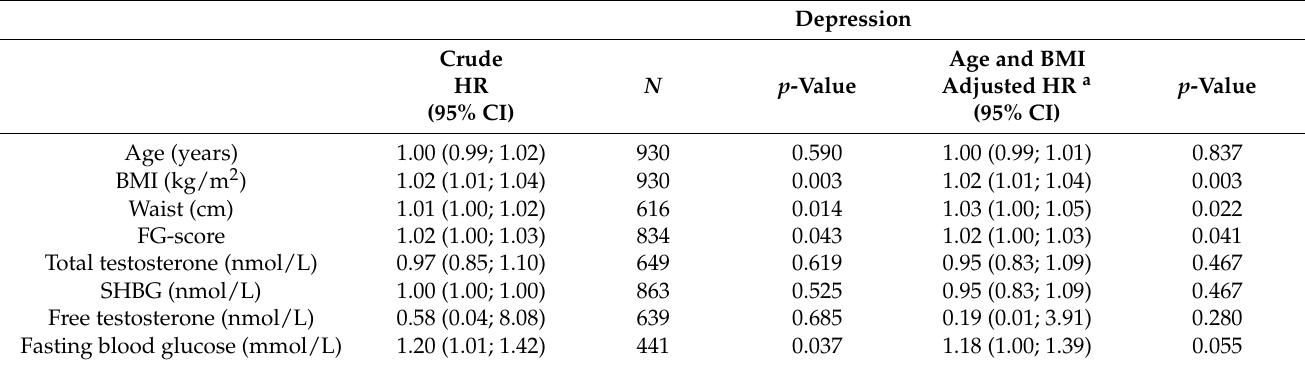
Table 6. Crude and adjusted Hazard ratios in PCOS OUH and development of depression ( N = 930).